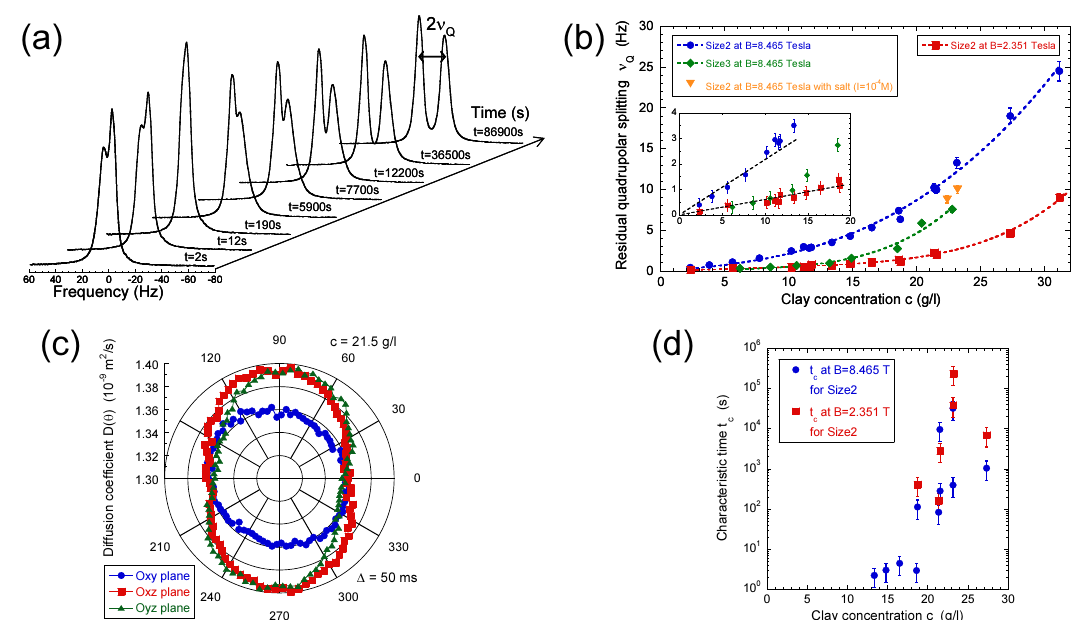
Figure 5. ( a ) 2 H NMR spectra recorded during the recovery of the residual quadrupolar splitting ν Q after a 90 ◦ rotation of a previously equilibrated clay sample; ( b ) Concentration variations of the limiting equilibrium residual quadrupolar splitting ν Q measured at B 0 = 2.351 and 8.465 Tesla for the Size2 clay samples and at B 0 = 8.465 Tesla for the Size3 clay samples. Additional measurements are performed at B 0 = 8.465 Tesla for the Size2 samples in the presence of salt ( I = 10 − 4 M); ( c ) Determination of the various components of self-diffusion tensor D of the water molecules in the Size2 clay sample (c = 21.5 g/L) measured by the 2 H NMR PGSE method at B 0 = 2.351 Tesla. The PGSE measurements are performed after equilibration of the clay platelet orientation in the static magnetic field B 0 parallel to the (cid:126) e z director; ( d ) Concentration variation of the characteristic time t c measured at B 0 = 2.351 and 8.465 Tesla for the Size2 clay samples. Reprinted with permission from [49]. Copyright (2010) American Chemical